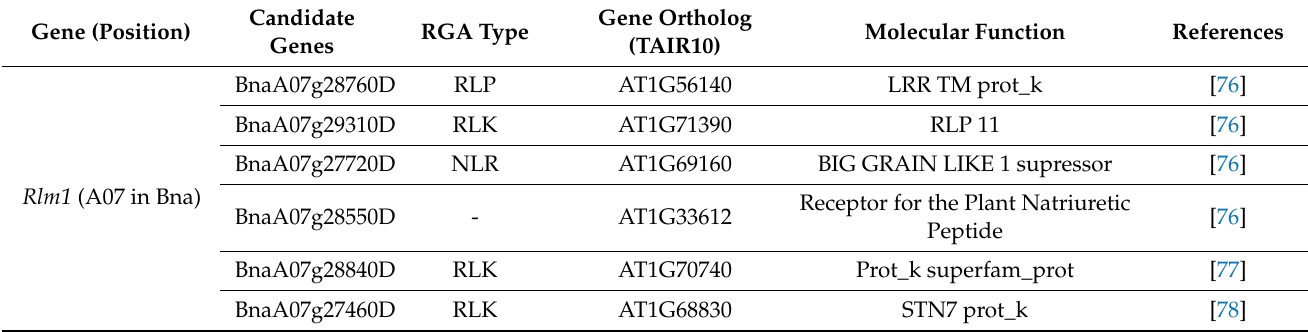
Receptor for the Plant